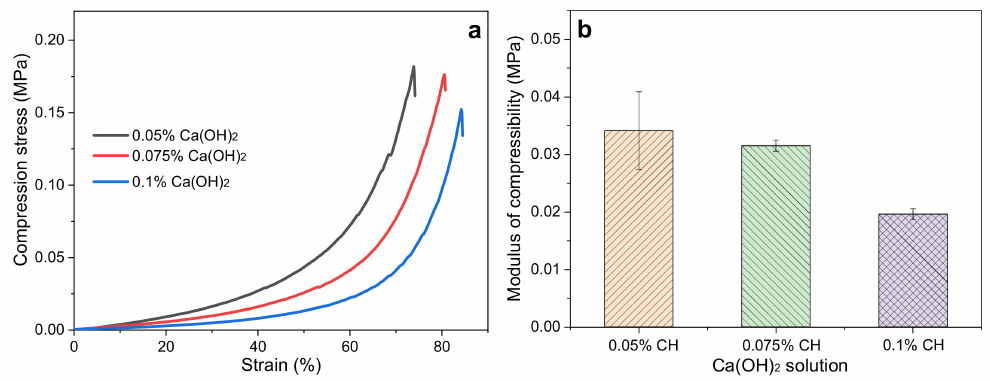
Figure 4. Effect of Ca(OH) 2 concentration on the mechanical properties of the subsequently synthe- sized pure SF scaffolds: ( a ) stress–strain curve; ( b ) compressive modulus.